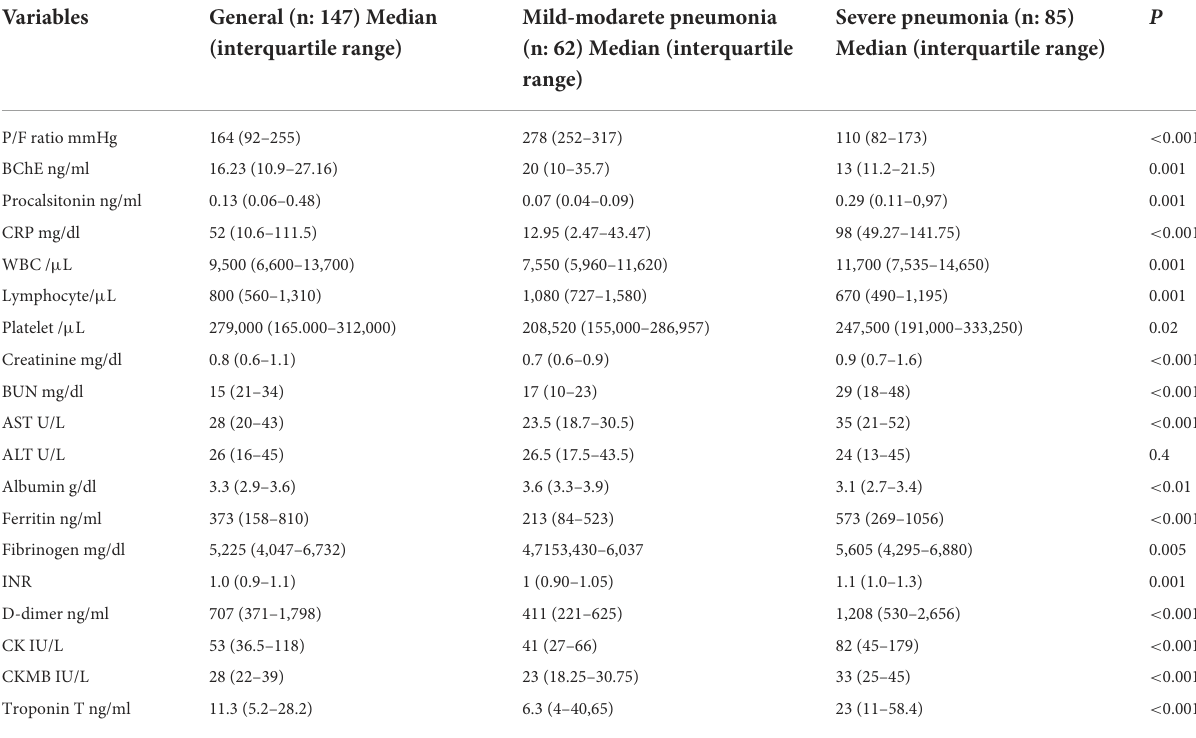
TABLE 2 Risk factors affecting the severity of COVID-19 pneumonia.